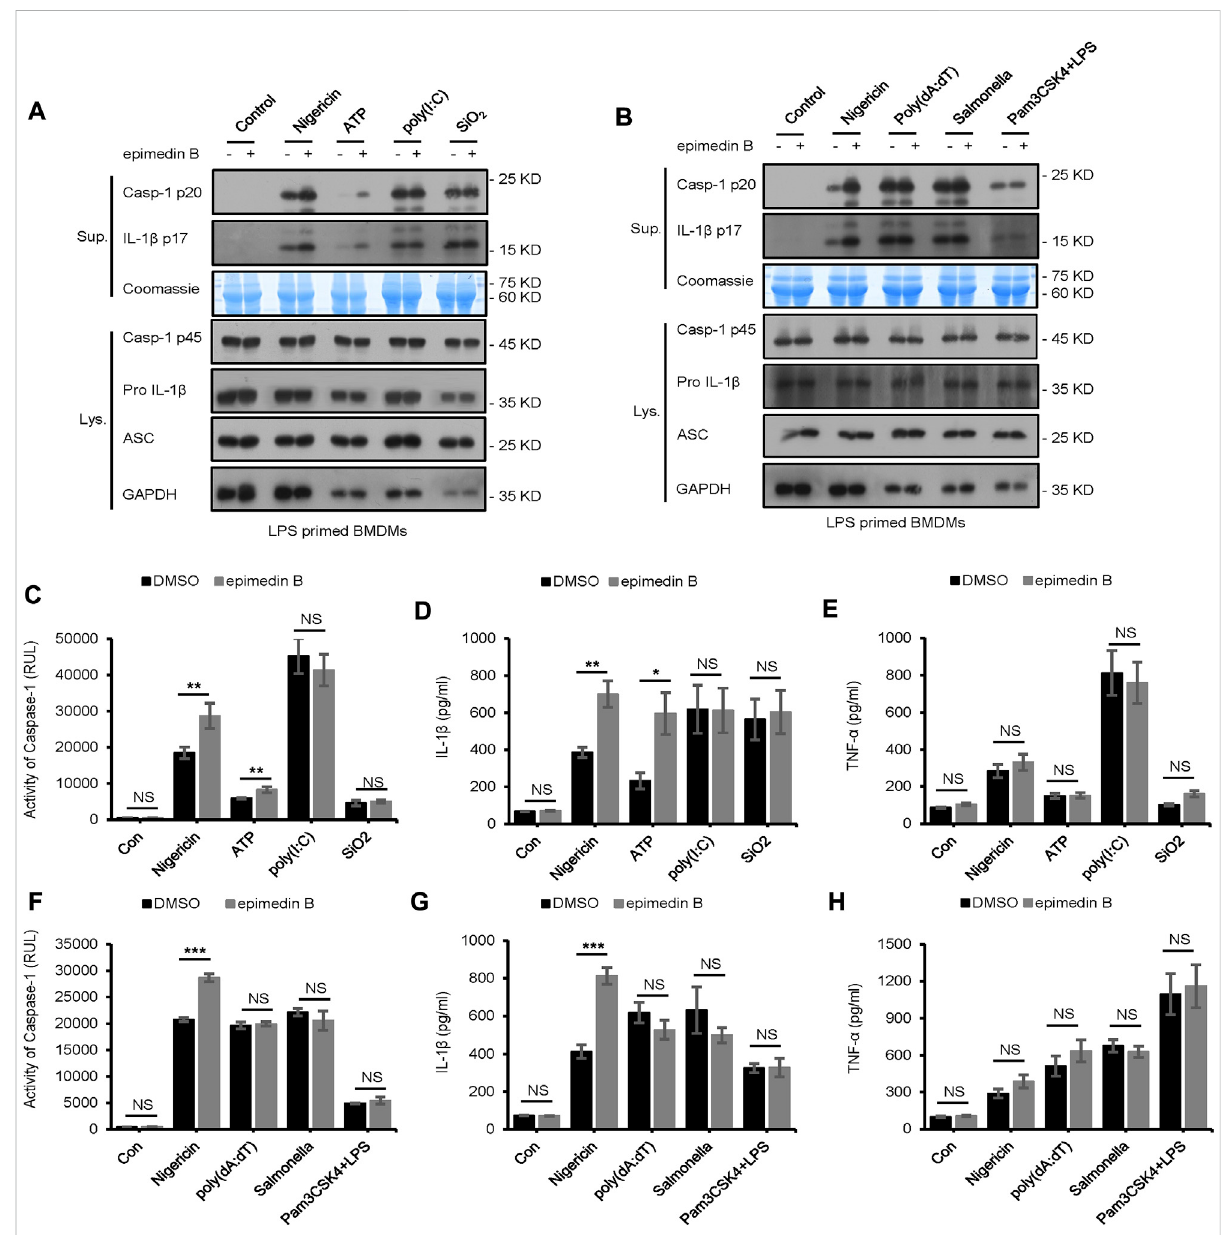
FIGURE 4 Epimedin B does not affect NLRP3 in fl ammasome activation induced by SiO2, poly (I:C), and intracellular lipopolysaccharide, as well as AIM2andNLRC4in fl ammasome. (A,B)